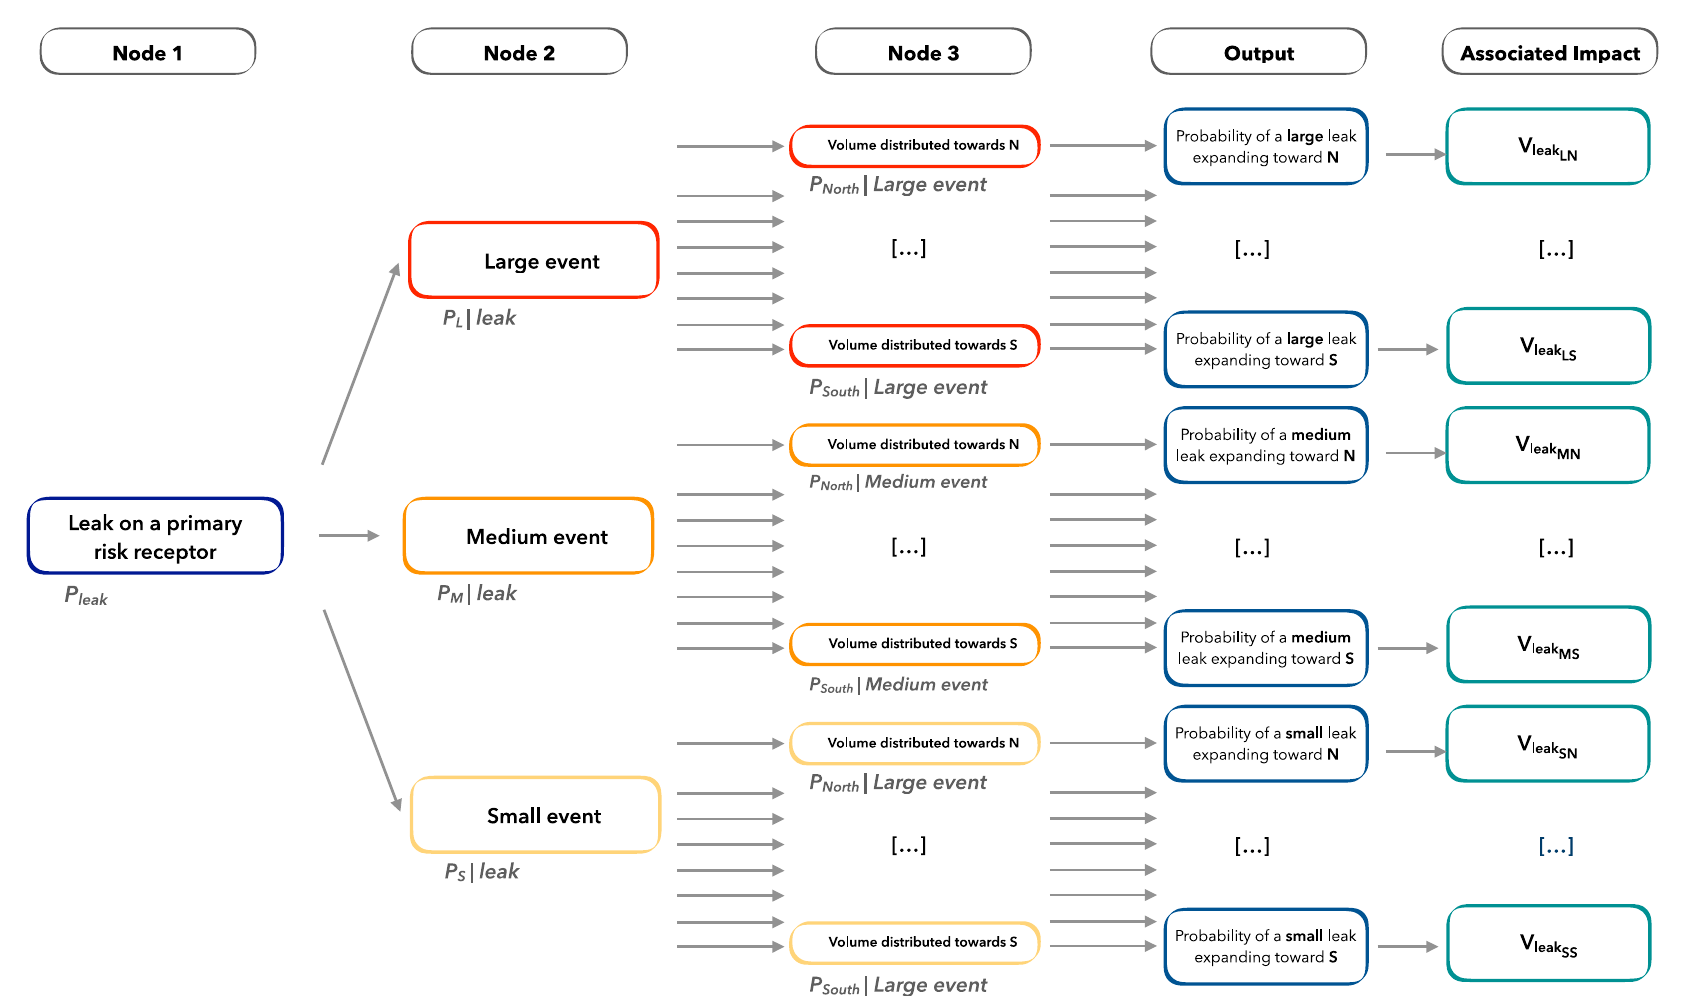
Figure 14. Template of the event tree defined for assessing impacts on primary risk receptors considering the spatial distribution of the leakage for Phase 1: Site construction and drilling.